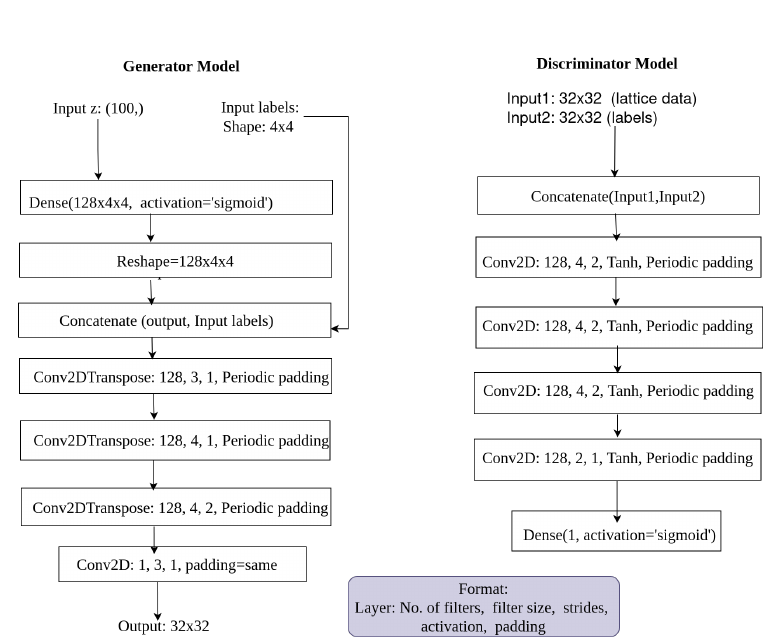
Figure 23: Architecture of C-GAN models: Generator and Discriminator